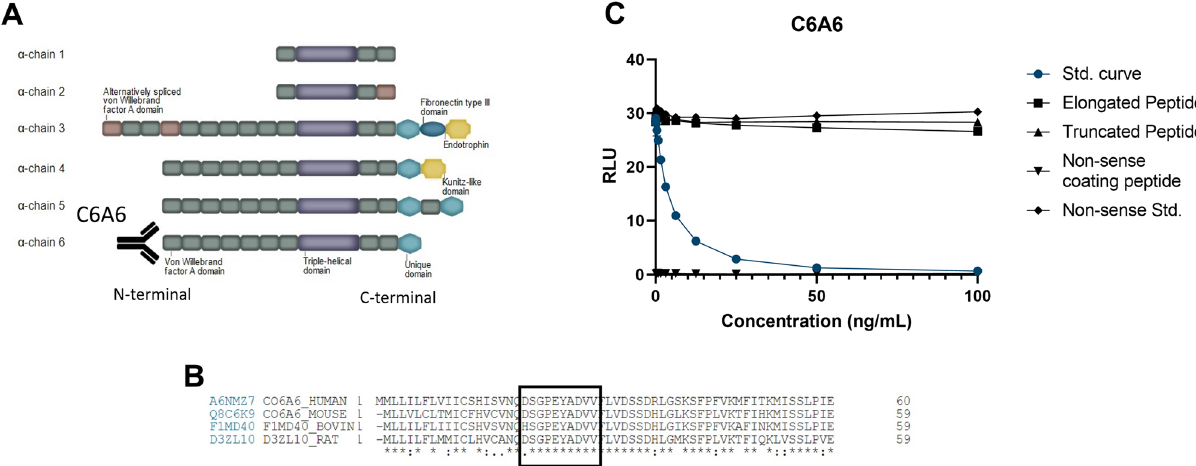
Figure 1. Overview of type VI collagen, the target of C6A6 and assay specificity. ( A ) The primary structure of type VI collagen including domains from all six alpha-chains, ( B ) Sequence alignment of the targeted COL6Α6 sequence in human, mouse, bovine and rat species (black box). The sequence was aligned using Uniprot, ( C ) Specificity of the C6A6 assay. Reactivity towards the standard peptide (DSGPEYADVV), truncated peptide (SGPEYADVV), elongated peptide (QDSGPEYADVV) and non-sense standard peptide (YRDDLKKLLE). No background signal was detected when coating with a non-sense coating peptide (YRDDLKKLLE-Biotin). Signals are shown as relative luminescence (RLU) per second, as a function of standard peptide.